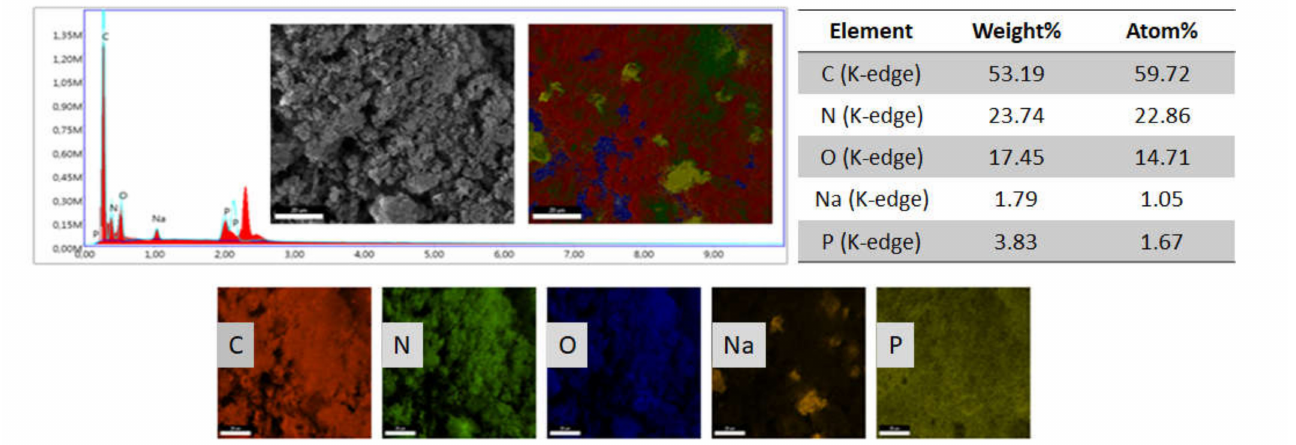
Figure 3. EDX spectrum of PANI